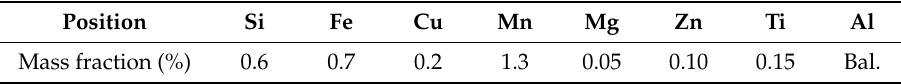
Table 1. Chemical composition of 3A21-O aluminum alloy.